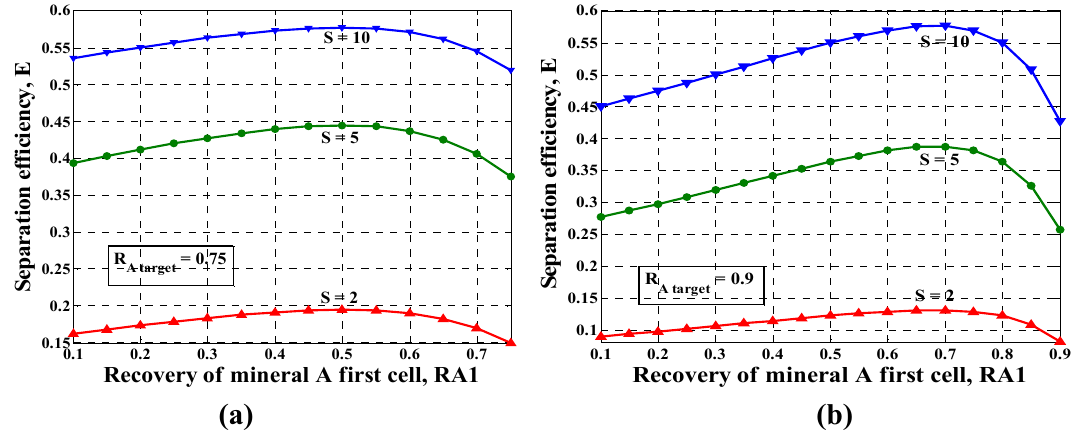
Figure 7. Separation efficiency vs. recovery of mineral A in the first cell for a bank composed of 2 cells and three relative floatabilities. ( a ) Target cumulative recovery of mineral A 0.75; ( b ) Target cumulative recovery of mineral A 0.9.